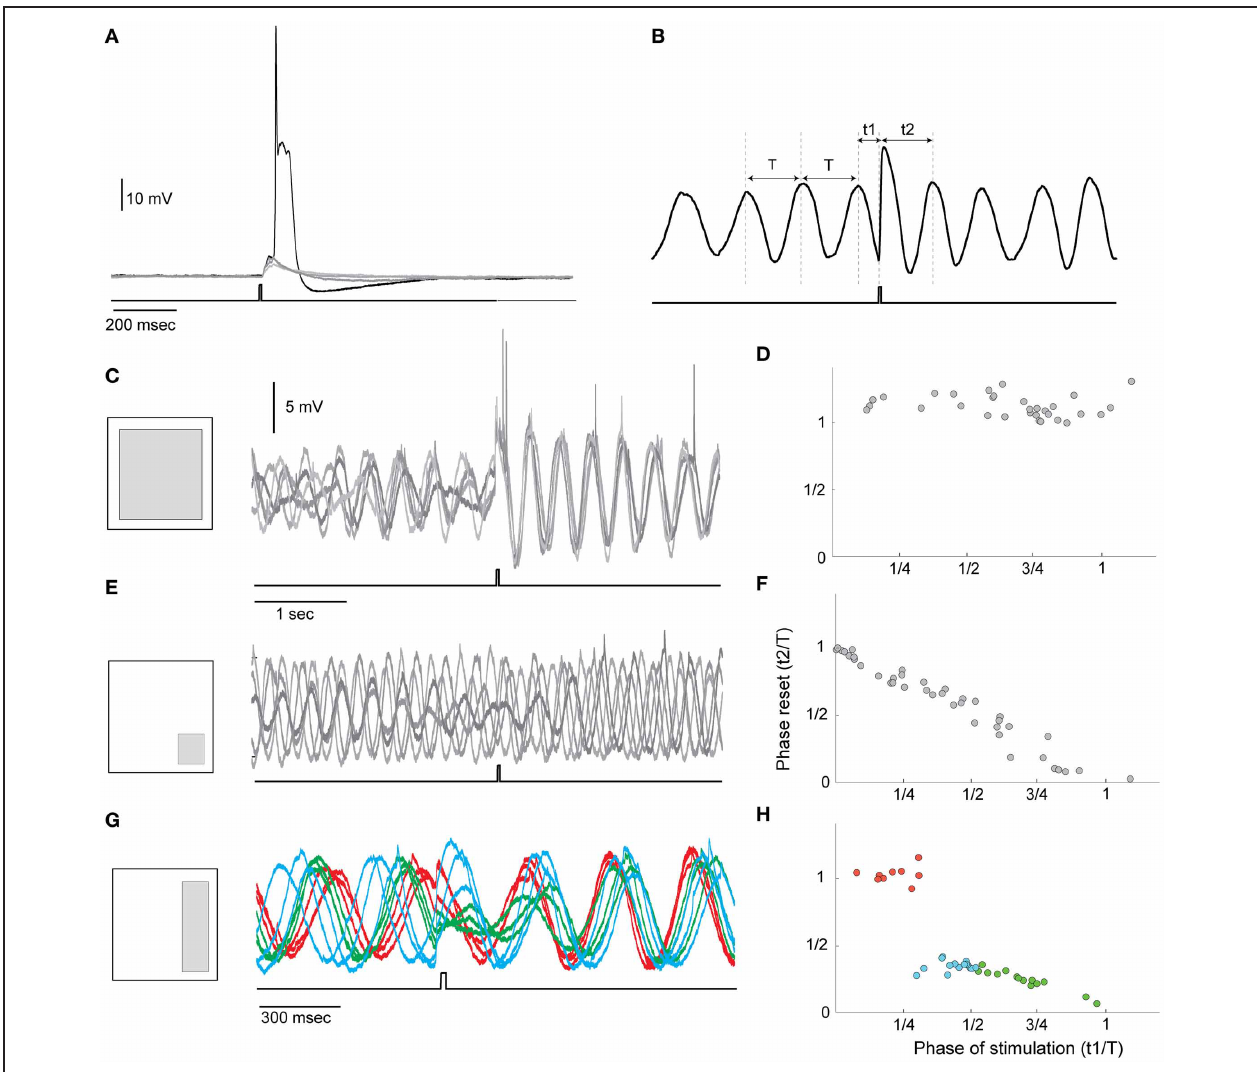
FIGURE 4 | Phase resetting of the STO by light stimulation. (A) Superimposed traces of olivary neuron responses to a single pulse of light (lower trace). Led blue light (460nm) was delivered to the slice using Digital Mirror Light Stimulator to illuminate specific areas at the resolution of 20 × 20 micron in × 40 objective. The system enables simultaneous illumination of multiple areas at a time resolution of 2ms. Note that the synaptic potential occasionally reached the threshold for spike initiation. (B) The method used to quantify the resetting of the STO by light. T is the cycle period and t1 and t2 are the time of the stimulus and the time of the first peak after the stimulus, respectively. (C) Left, Schematic illustration of the illuminated area;